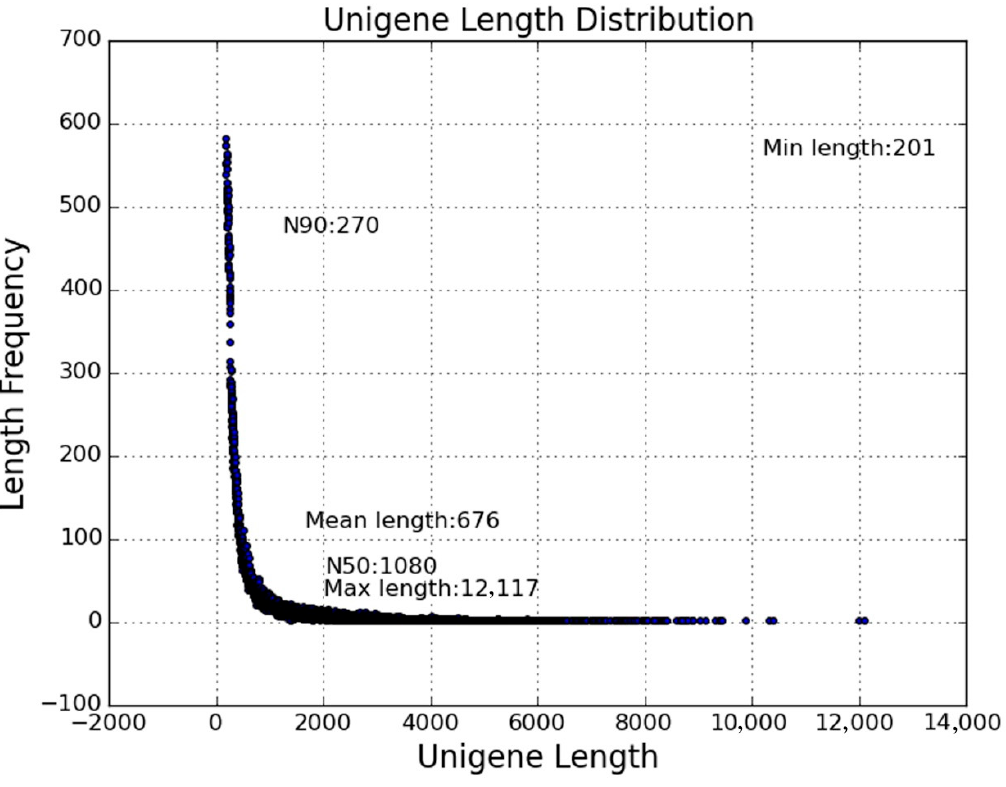
Figure 1. Unigenes length distribution in D.odorifera transcriptome. Horizontal and vertical axes show the size and number of unigenes, respectively.